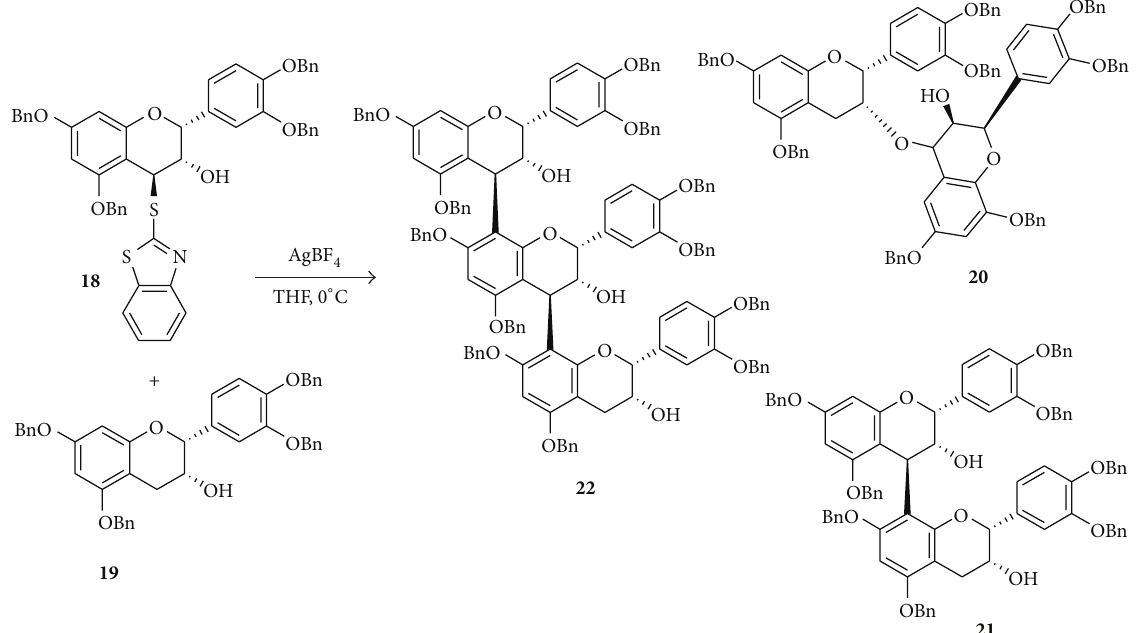
Scheme 2: Synthesis of procyanidin oligomers using 4-[(2-benzothiazolyl)thio]